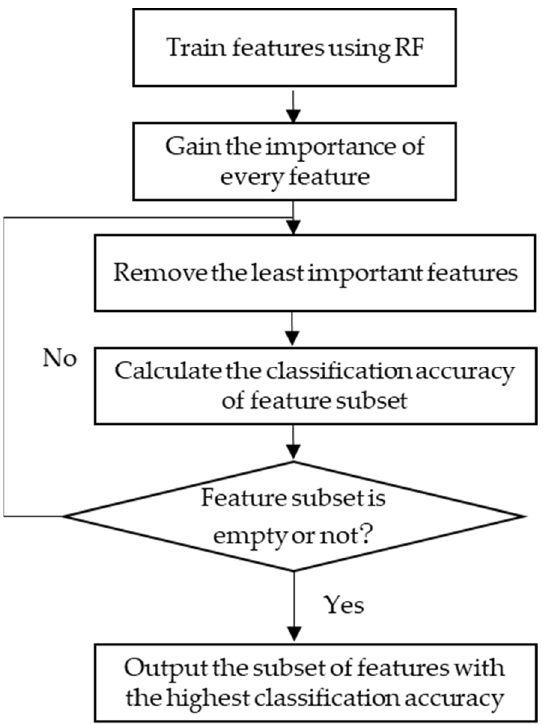
Figure 3. The main procedure of the RFECV method.